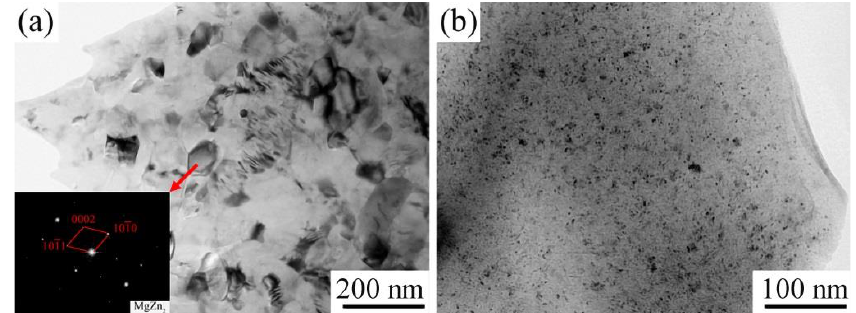
Figure 12. TEM figures of Al-Zn-Mg-Cu alloy: ( a ) 0.1 s − 1 , 673 K; ( b ) 0.1 s − 1 , 773 K.